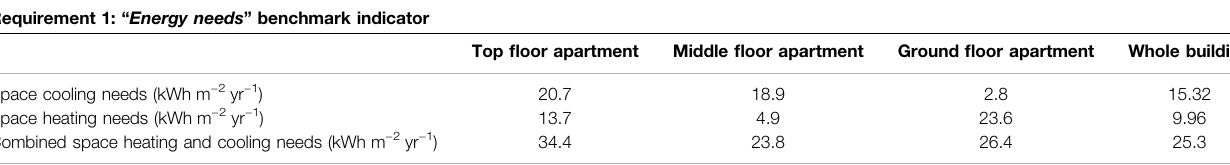
TABLE 3 | The fi rst nearly zero energy buildings (NZEB) benchmark indicator. Requirement 1: “ Energy needs ” benchmark